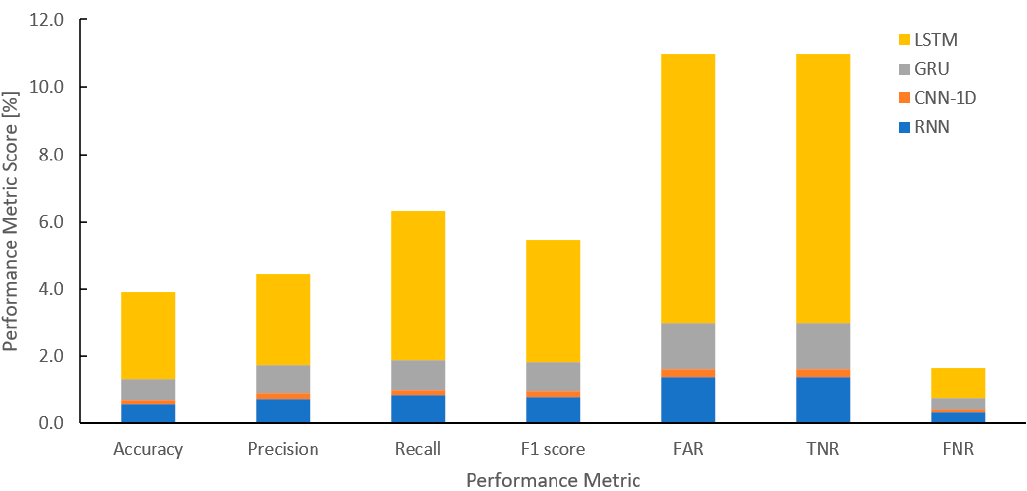
Figure 6. Performance of different DL-based IDS schemes in terms of FAR and FNR.